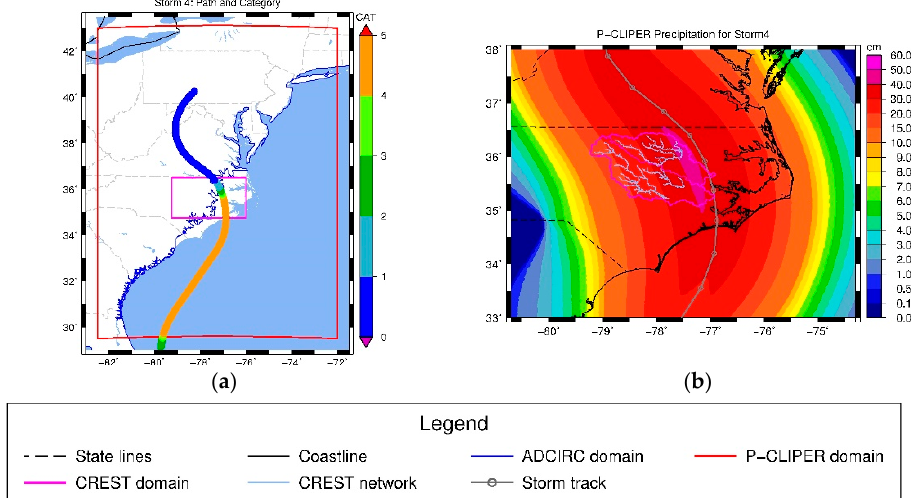
Figure 12. Meteorological input for Storm 4 in the stochastic STORM-CoRe process: ( a ) hourly synthetic hurricane track with storm strengths denoted by color scale (CAT4 at landfall and maximum within PCLIPER domain), ( b ) Accumulated precipitation (cm) near CREST model from P-CLIPER (CAT4 storm, f = 0.31).